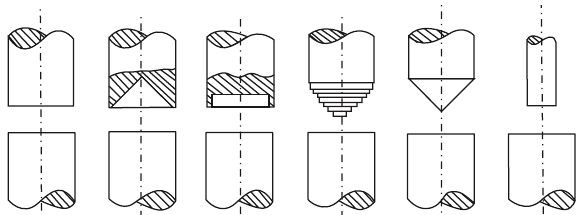
Figure 8: The scheme of the shapes of the friction welded AlMg3 aluminium alloy-X10CrNiTi189 austenitic steel joints’ surfaces, used in the investigations